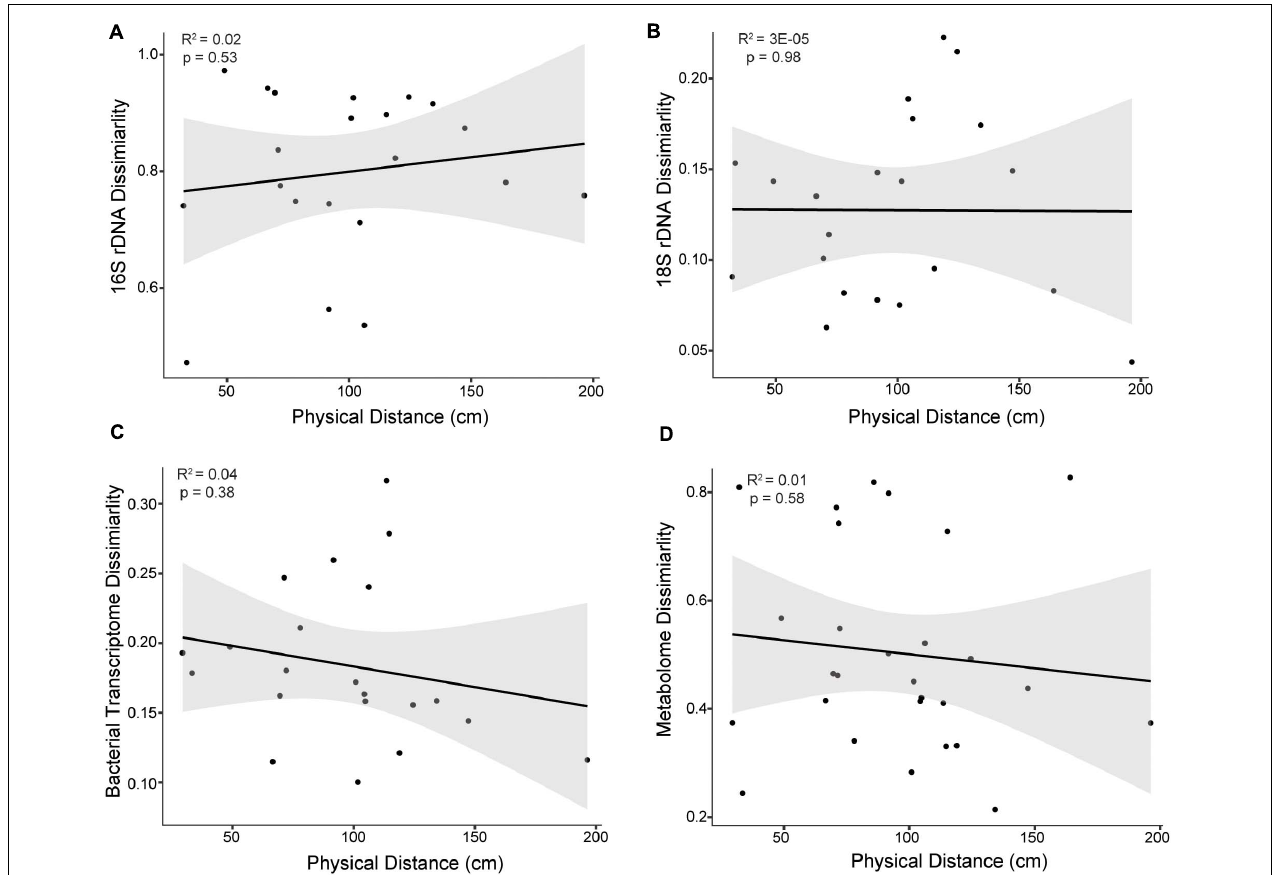
FIGURE 2 | Bray-Curtis dissimilarity of (A) 16S rDNA, (B) 18S rDNA, (C) bacterial transcriptomes, and (D) metabolomes as a function of the physical distance between samples of the East Point Orbicella faveolata colony. The physical distance represents the shortest distance between two sample points along the 3D coral model surface. No significant correlations were observed ( p > 0.05) and similar results were found for the Water Factory O. faveolata colony. Black lines represent the fit line and gray areas represent the fit confidence (95%).